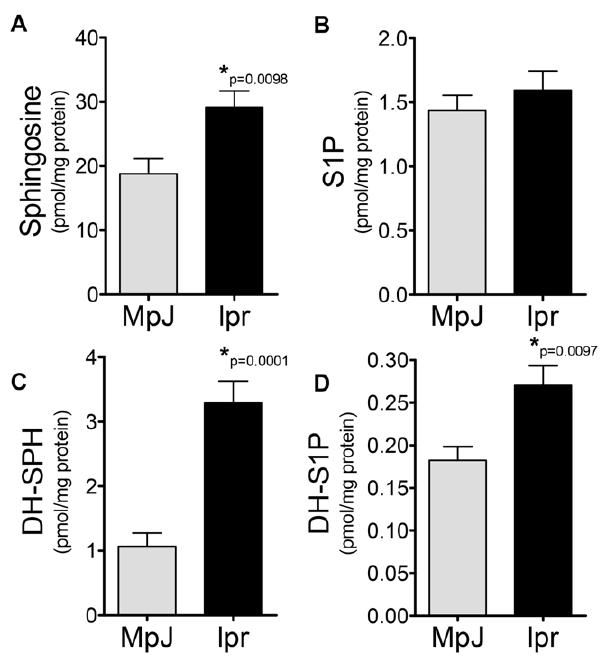
Figure 2. Sphingoid bases are elevated in kidney tissue from lupus mice. At 20 weeks of age, kidney tissue was collected from MRL/ lpr and MRL/MpJ mice, homogenized and analyzed for sphingolipid content by the Lipidomics Shared Resource at MUSC, A ) sphingosine, B ) S1P, C ) Dh-sphingosine and D ) Dh-S1P. Data represent mean 6 SEM,